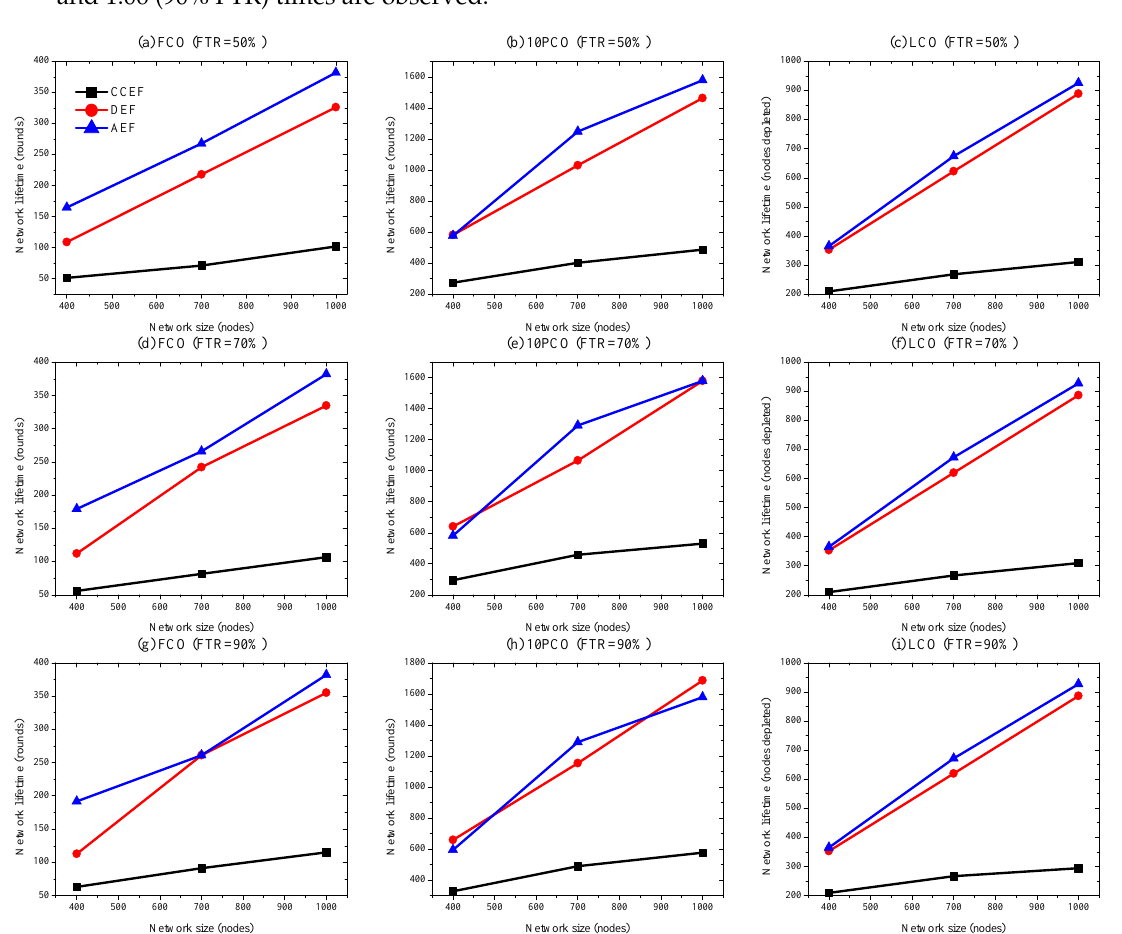
Figure 6. Network lifetime: six simulation experimental setups using FCO, 10PCO, and LCO for 50% and 70% false traffic ratios (FTRs) for network sizes of 400, 700, and 1000 nodes. It can be observed that, with an increase in the number of the FTRs or the rounds, the relative improvement in network lifetime decreases. However, there is no set trend; however, the larger the number of rounds for a small network size, the more the margin of improvement decreases. This trend by part is because of random deployment, different network sizes, and dynamic path selection. It can be observed from Table 2 that there is significant improvement against CCEF. There is also network lifetime gain against DEF; however, the margin of improvement is less. The reason is because DEF considers energy-aware